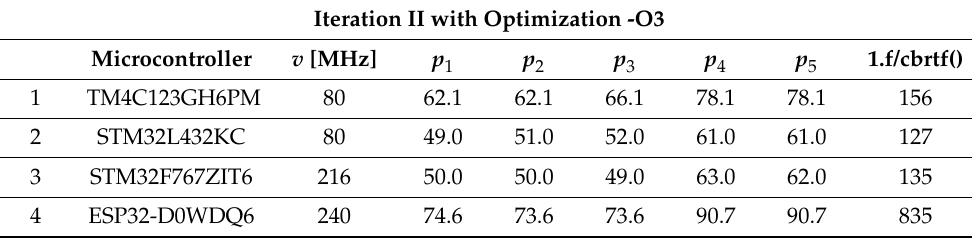
Table 5. The results of algorithm performance on different microcontrollers for Iteration